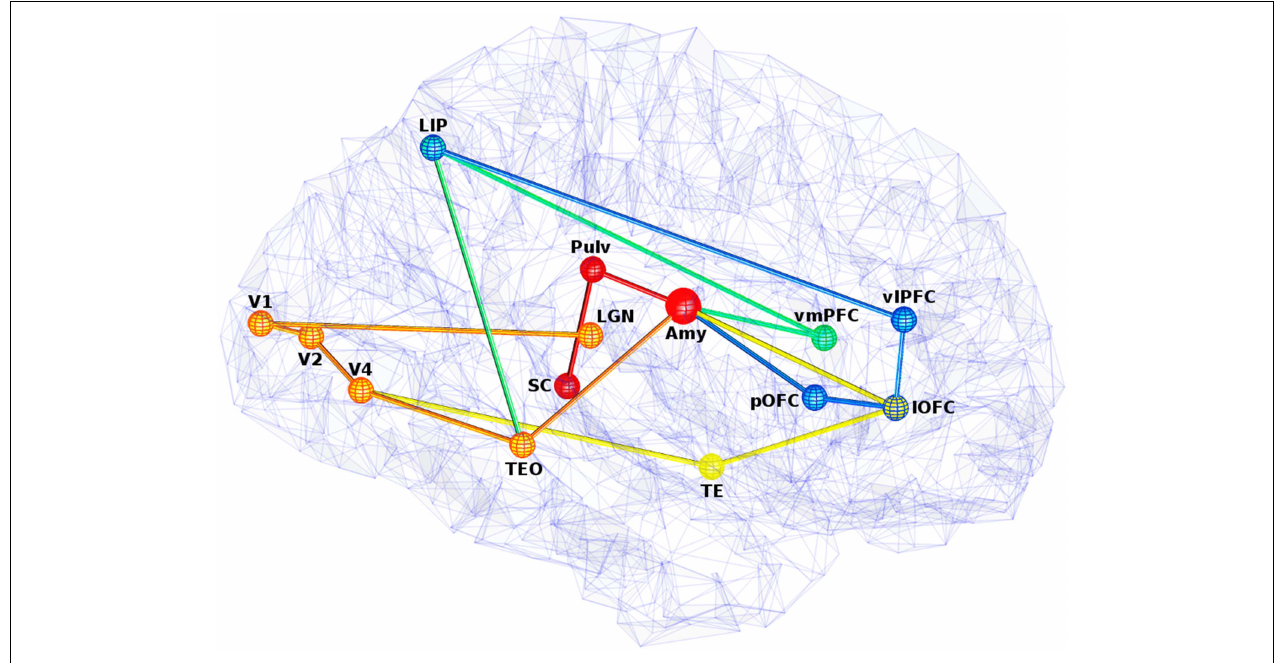
FIGURE 3 | View of five visual fear signaling pathways to the amygdala. Abbreviations are described in Table 1 . Pathways p1 is red, p2 is orange, p3 is orange to yellow at V4, p4 is orange to green at TEO, and p5 is orange to green at TEO, then blue at